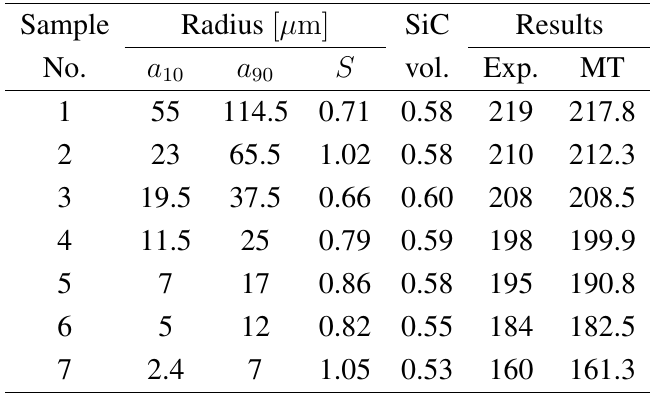
Table 2. Characteristics of SiC particles ( cf. [4, Table 1]), and comparison of effective thermal conductivity χ H [ Wm − 1 K − 1 ] between experimental measurements [4] and MT predictions